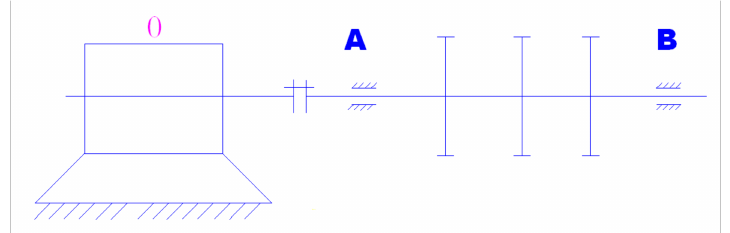
Figure 11. Schematic diagram of the experimental platform.